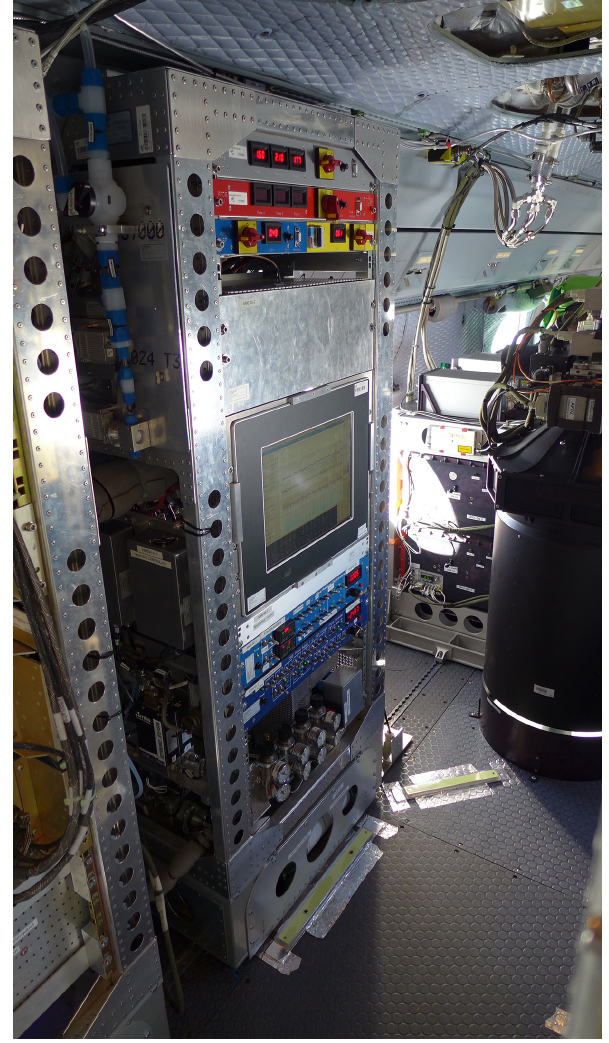
Figure 1. Front view of instrument rack in AIMS-H 2 O configura- tion integrated in a HALO standard rack. The inlet line is connected to a trace gas inlet (TGI) mounted at the top fuselage of the aircraft.